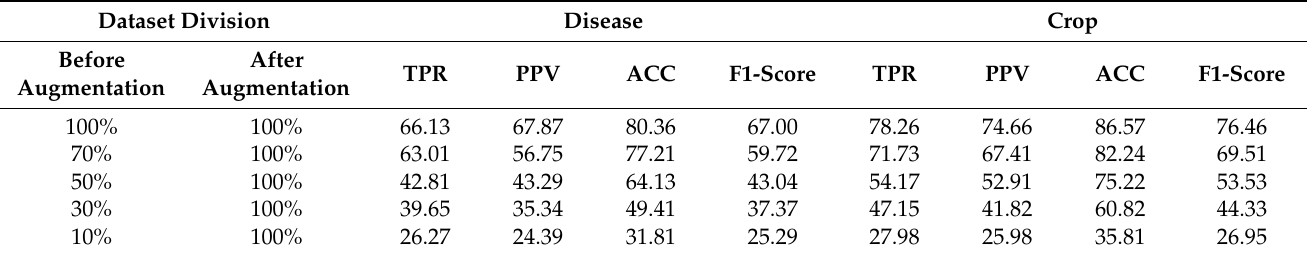
Table 29. Comparison of accuracies achieved by the proposed PI-CNN in the original and PI-GAN- augmented datasets. The accuracies were achieved in the PlantDoc dataset (unit: %).